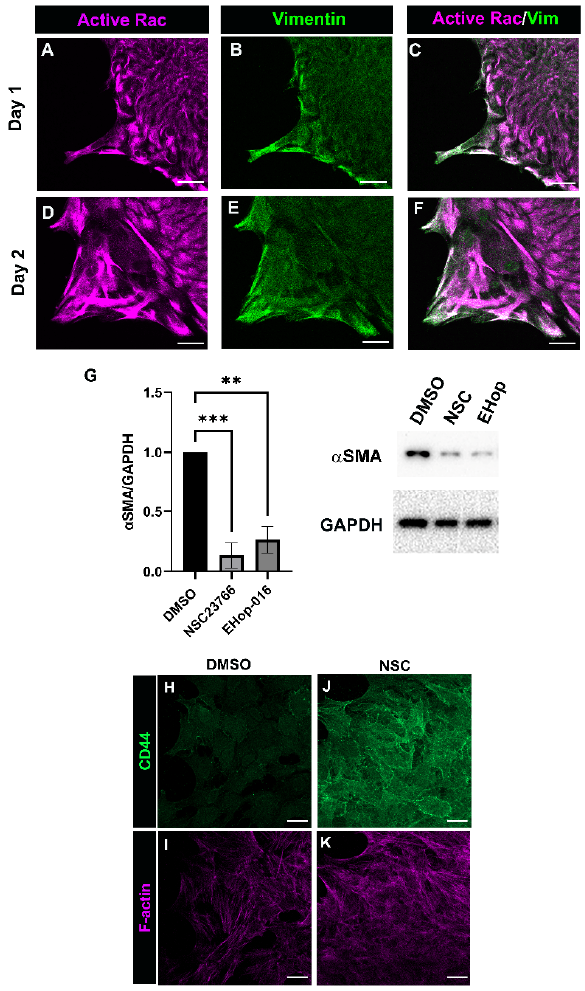
Figure 4. Rac signaling is involved in inducing myofibroblast differentiation. ( A – F ) Ex vivo post- cataract surgery explant cultures at ( A – C ) D1 and ( D – F ) D2 were immunolabeled for active Rac ( A , D ) and vimentin ( B , C , E , F ) and imaged at the leading edge by confocal microscopy. ( C , F ) Image overlays for Rac and vimentin show their co-localization to protrusions extended by leader cells. Images are presented as a single optical plane from the collected confocal z-stack with each optical plane at 0.49 µm. Magnification bar = 20 µm. ( G ) Ex vivo post-cataract surgery explants were treated with vehicle (DMSO) or Rac specific inhibitors NSC23766 (NSC) or EHop-016 (EHop) on day 1 through day 3 post-injury and subjected to immunoblot analysis for α SMA and the loading control GAPDH. Quantification of the relative intensity of α SMA and GAPDH normalized to DMSO is dis- played in bar graphs ( n = 3 for NSC23766, n = 2 for EHop-016). Results show that Rac signaling is involved in inducing α SMA expression. ( H – K ) Ex vivo post-cataract surgery explants cultured for 48hrs in the presence of either DMSO or NSC were labeled for CD44 ( H , J ) and F-actin ( I , K ) and imaged at the leading edge by confocal microscopy. Results show that CD44 expression was re- tained by leader cells culture in the presence of NSC. Images are presented as projected images from collected confocal z-stacks ( H , J ). Images for F-actin labeling are shown as a single optical plane from collected confocal z-stacks ( I , K ). Error bars represent S.E.M., ** p ≤ 0.01, and *** p ≤ 0.001.